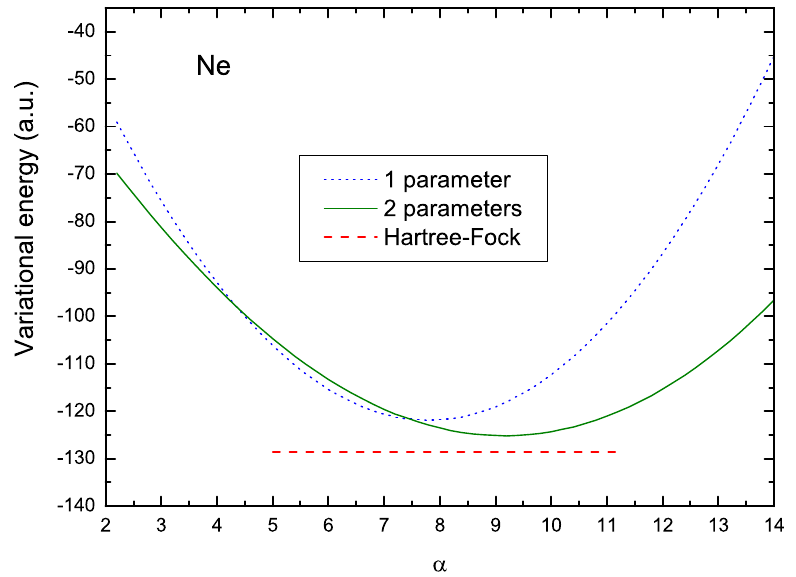
Figure 2. Variational energy as a function of parameter α for the V1 and V2 formulations. The dotted curve in this figure shows the values of the energy E ( α ) corresponding to the V1 case; the solid line shows the values of the energy E ( α , β ) for the V2 case and for a fixed value of β . The red dashed line represents the HF